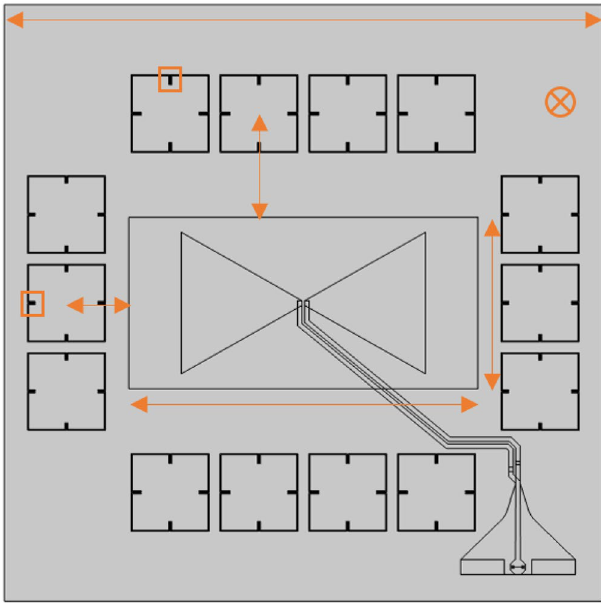
Figure 4. Snapshot of the simulated MM-loaded antenna with highlighted variables for the optimization. Figure created with COMSOL Multiphysics 5.5 (https:// www. comsol. com/).